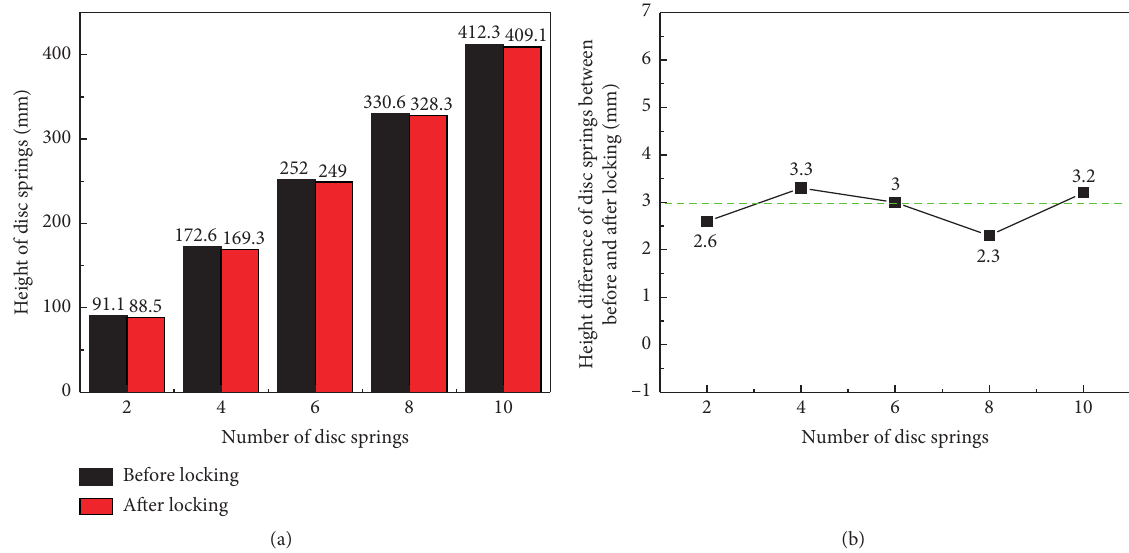
Figure 10: Height of the disc spring system before and after preloading in the constraint mode of locking and no preloading under different numbers of disc springs.